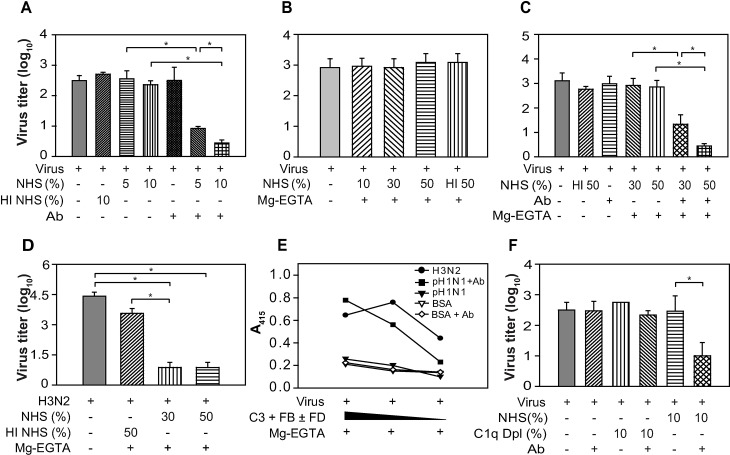
A(H1N1)pdm09 virus neutralization by human complement.A) CP-mediated neutralization of A(H1N1)pdm09 virus by NHS in the presence or absence of antibody. B) AP-mediated neutralization of A(H1N1)pdm09 virus by NHS in the presence of Mg-EGTA. C) Alternative pathway-mediated neutralization of A(H1N1)pdm09 virus in the presence of antibody and Mg-EGTA. D) AP-mediated neutralization of H3N2-A/Perth virus by NHS in the presence of Mg-EGTA. E) AP-mediated C3b deposition on H3N2-A/Perth09, and A(H1N1)pdm09 viruses in the presence or absence of antibody. F) A(H1N1)pdm09 virus neutralization by C1q depleted sera in the presence or absence of antibody. All the neutralization experiments were performed in an essentially similar manner to that performed with mouse complement. Results represent mean ± SD for three independent experiments except for panel E, which shows mean of two independent experiments. *p ≤ 0.05.